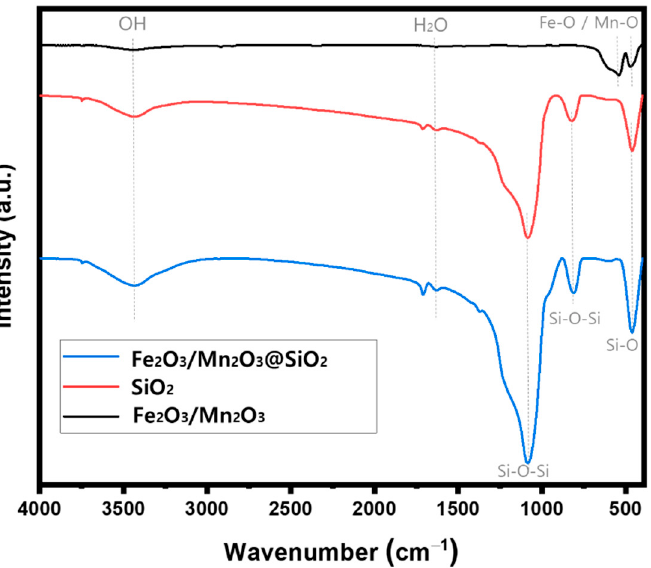
Figure 5. Fourier transform infrared (FTIR) spectra of synthesized photocatalyst; Fe 2 O 3 /Mn 2 O 3 na- noparticles (FM-NPs), Fe 2 O 3 /Mn 2 O 3 @SiO 2 (FMS), and bare SiO 2 . nanoparticles (FM-NPs), Fe 2 O 3 /Mn 2 O 3 @SiO 2 (FMS), and bare SiO 2